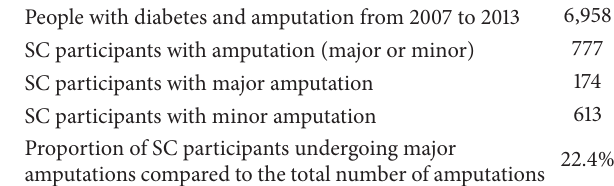
Table 1: Overview of selective contract (SC) participants and amputation